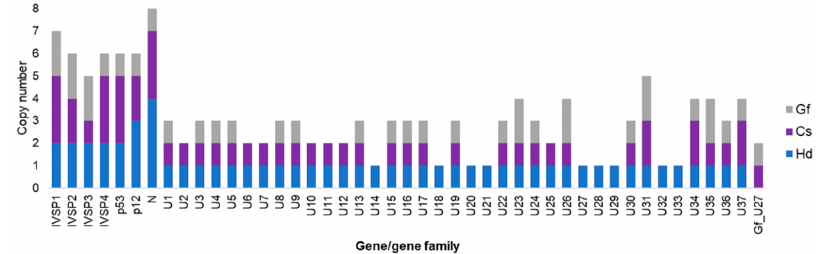
Figure 5. IVSPER gene conservation across ichneumonids. The numbers are for the copies of each gene or gene family identified in three ichneumonid species, Cs, Campoletis sonorensis (campoplegine); Gf, Glypta fumiferanae (banchine); Hd, Hyposoter didymator (campoplegine).